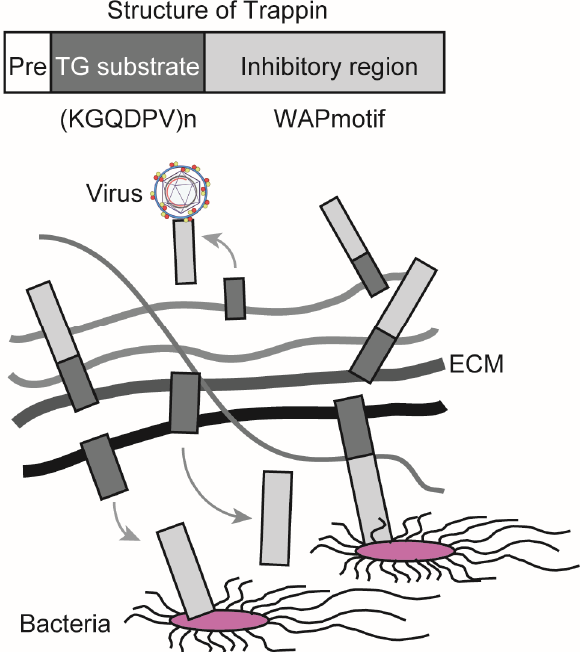
Figure 2. Trappin is responsible for antibacterial and antiviral activities. Trappin has a signal se- quence for secretion (Pre), a TG substrate domain with a repeat sequence KGQDPV, and an inhibitory region that has a whey acidic protein (WAP) motif. Trappin is crosslinked to the extracellular matrix (ECM) by TG, whereby an inhibitory region is released into the extracellular space. The WAP motif exerts antibacterial and antiviral activities.